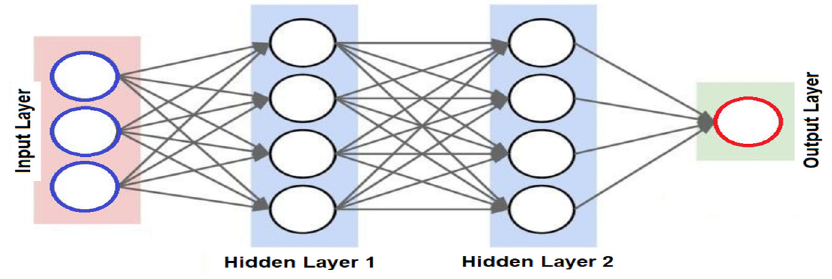
Figure 4. A Multilayer Neural Network .